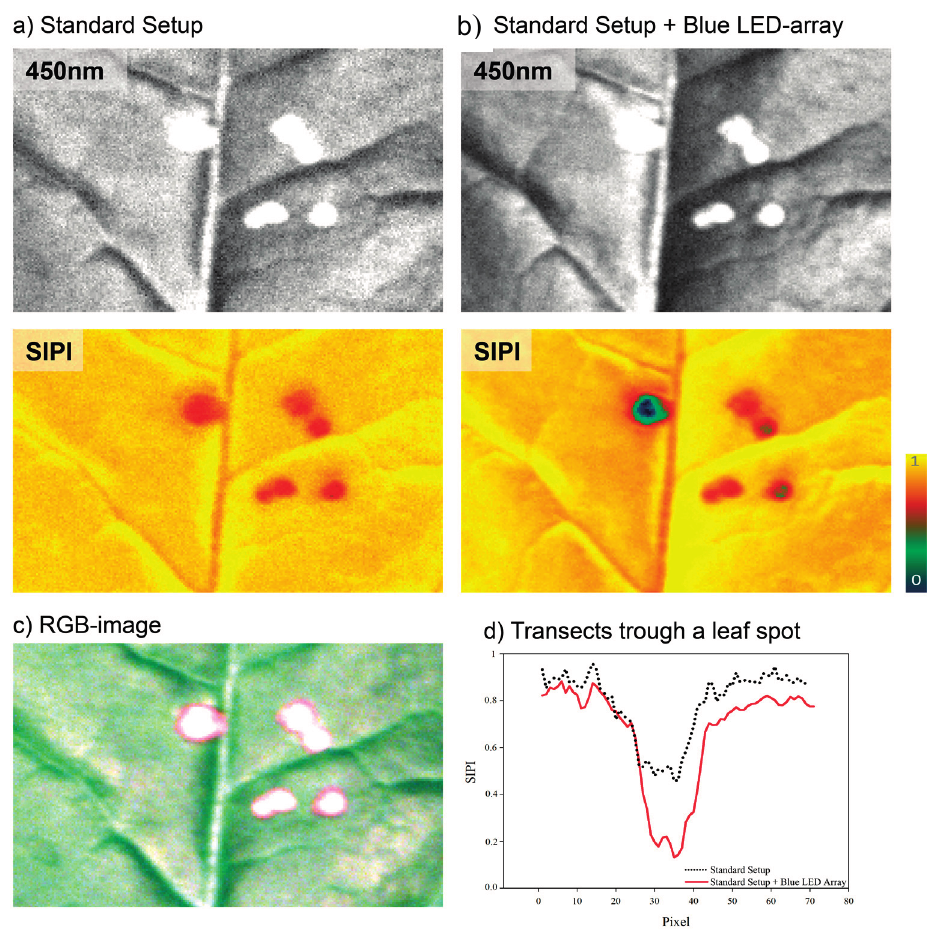
Figure 3. ( a ) Greyscale image of a region of sugar beet leaf diseased with Cercospora leaf spot, at 450 nm; ( b ) false colour images of the Structure Independent Pigment Index (SIPI) without and with the supplemental LED illumination; and ( c ) a digital red, green and blue (RGB) image of the sugar beet leaf. The greyscale and the SIPI image with additional illumination show apparently less noise, by this single structures are more distinctive and recognizable. This is further emphasized by transects through a leaf spot (indicated by dashed lines) ( d ), were SIPI values measured with the additional LED illumination source provides a more detailed and severable information of the diseased tissue. (Best viewed in